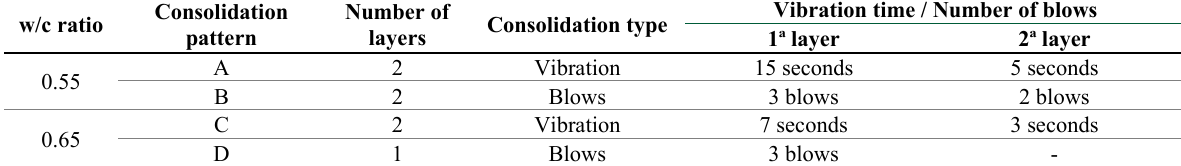
Table 4. Consolidation patterns